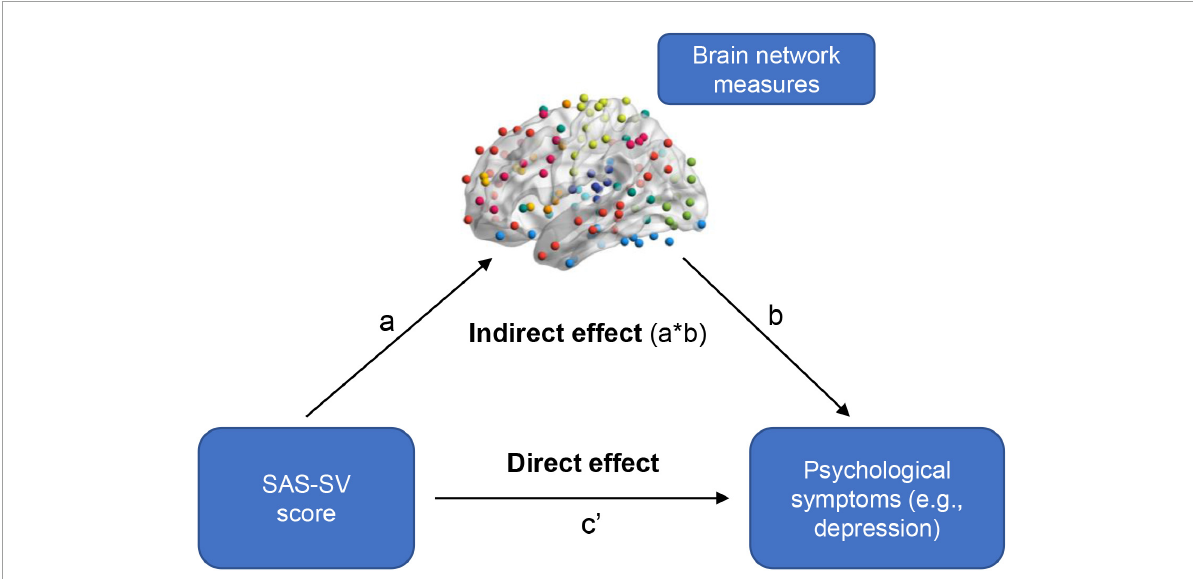
FIGURE2 A summary of how to test the mediation effects of brain network measures in the relationship between problematic smartphone use severity and psychological symptoms. A significant mediation occurred when the 95% confidence interval for the indirect effect did not include